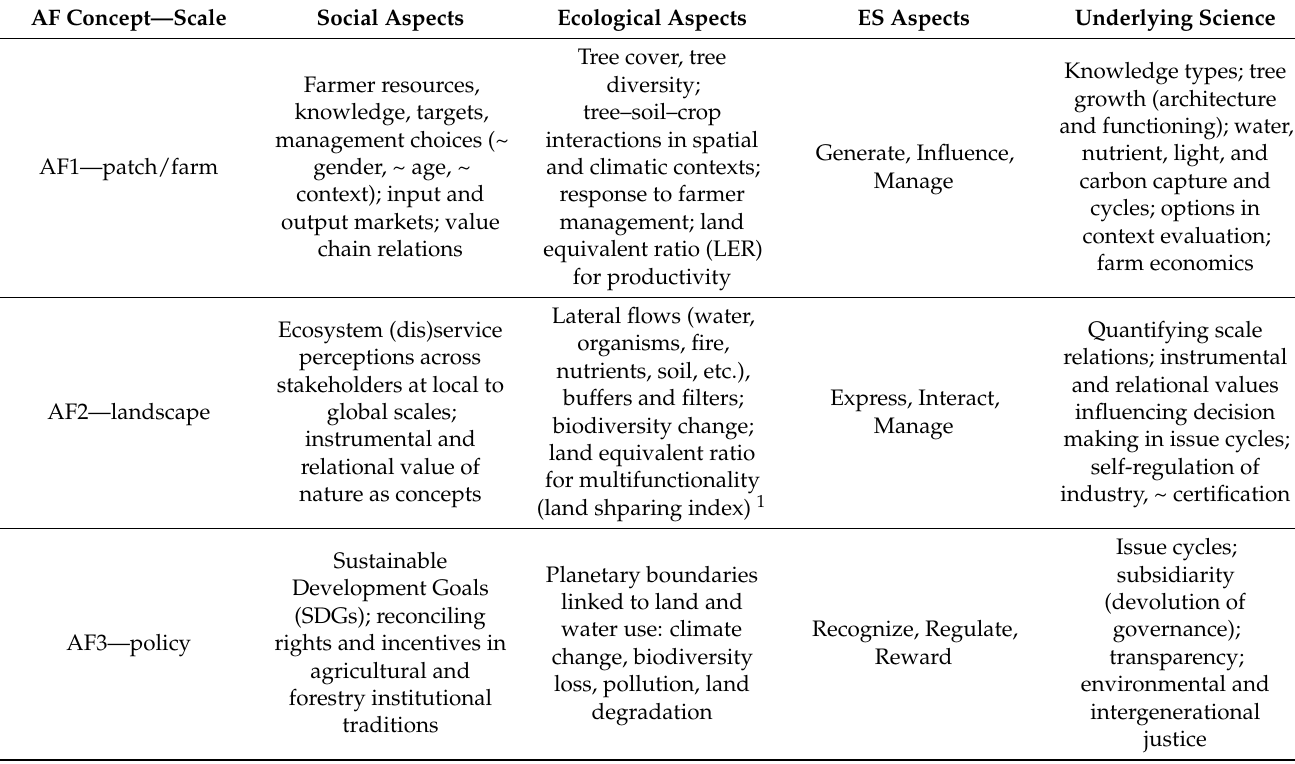
Table 1. Agroforestry (AF) concepts with their social and ecological aspects across scales, in relation to ecosystem services issues and underlying science. AF Concept—Scale Social Aspects Ecological Aspects ES